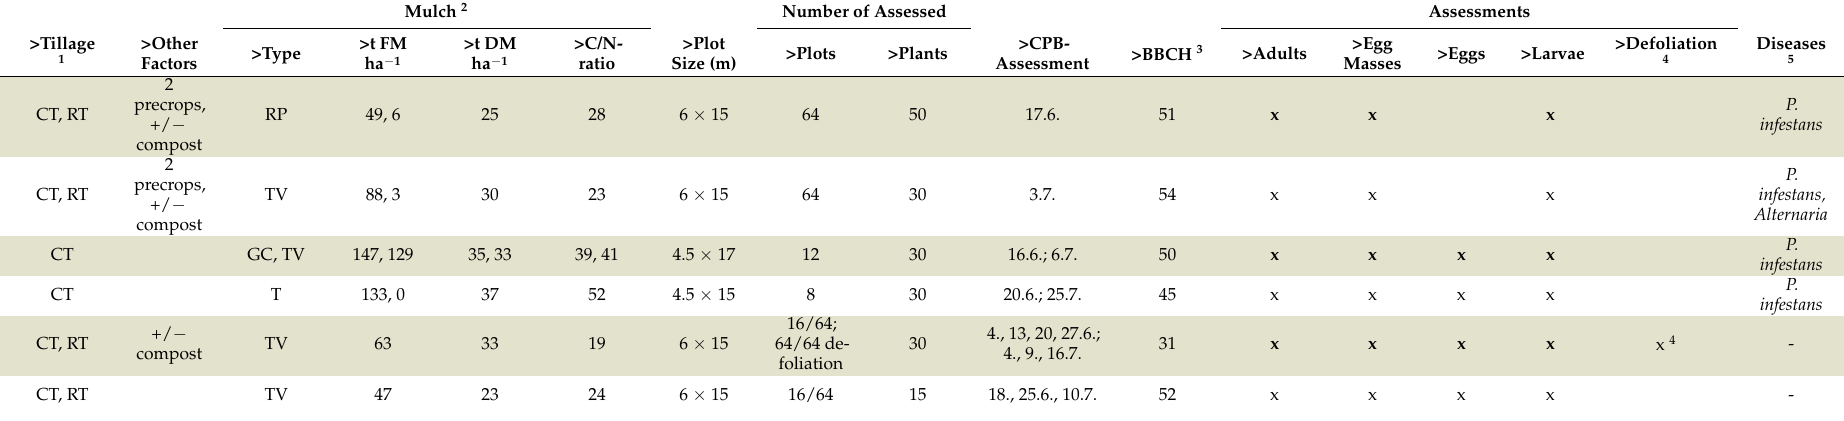
Table 2. Experimental factors and CPB and other relevant parameters assessed in the six experiments. All experiments were conducted with four replications. Mulch 2 Number of Assessed